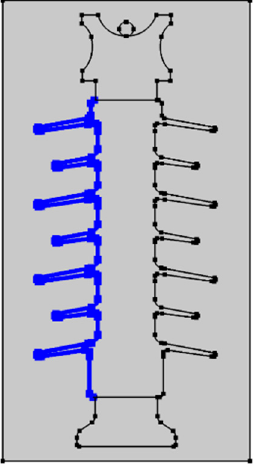
Figure 12. Selection of boundary isolators for line graph analysis.